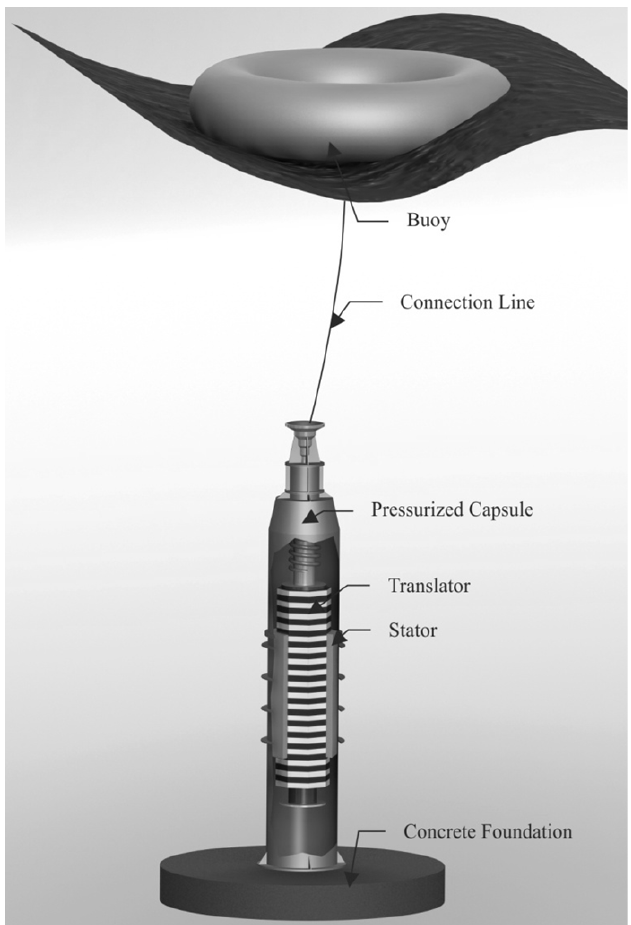
Figure 1. The wave energy converter developed by Uppsala